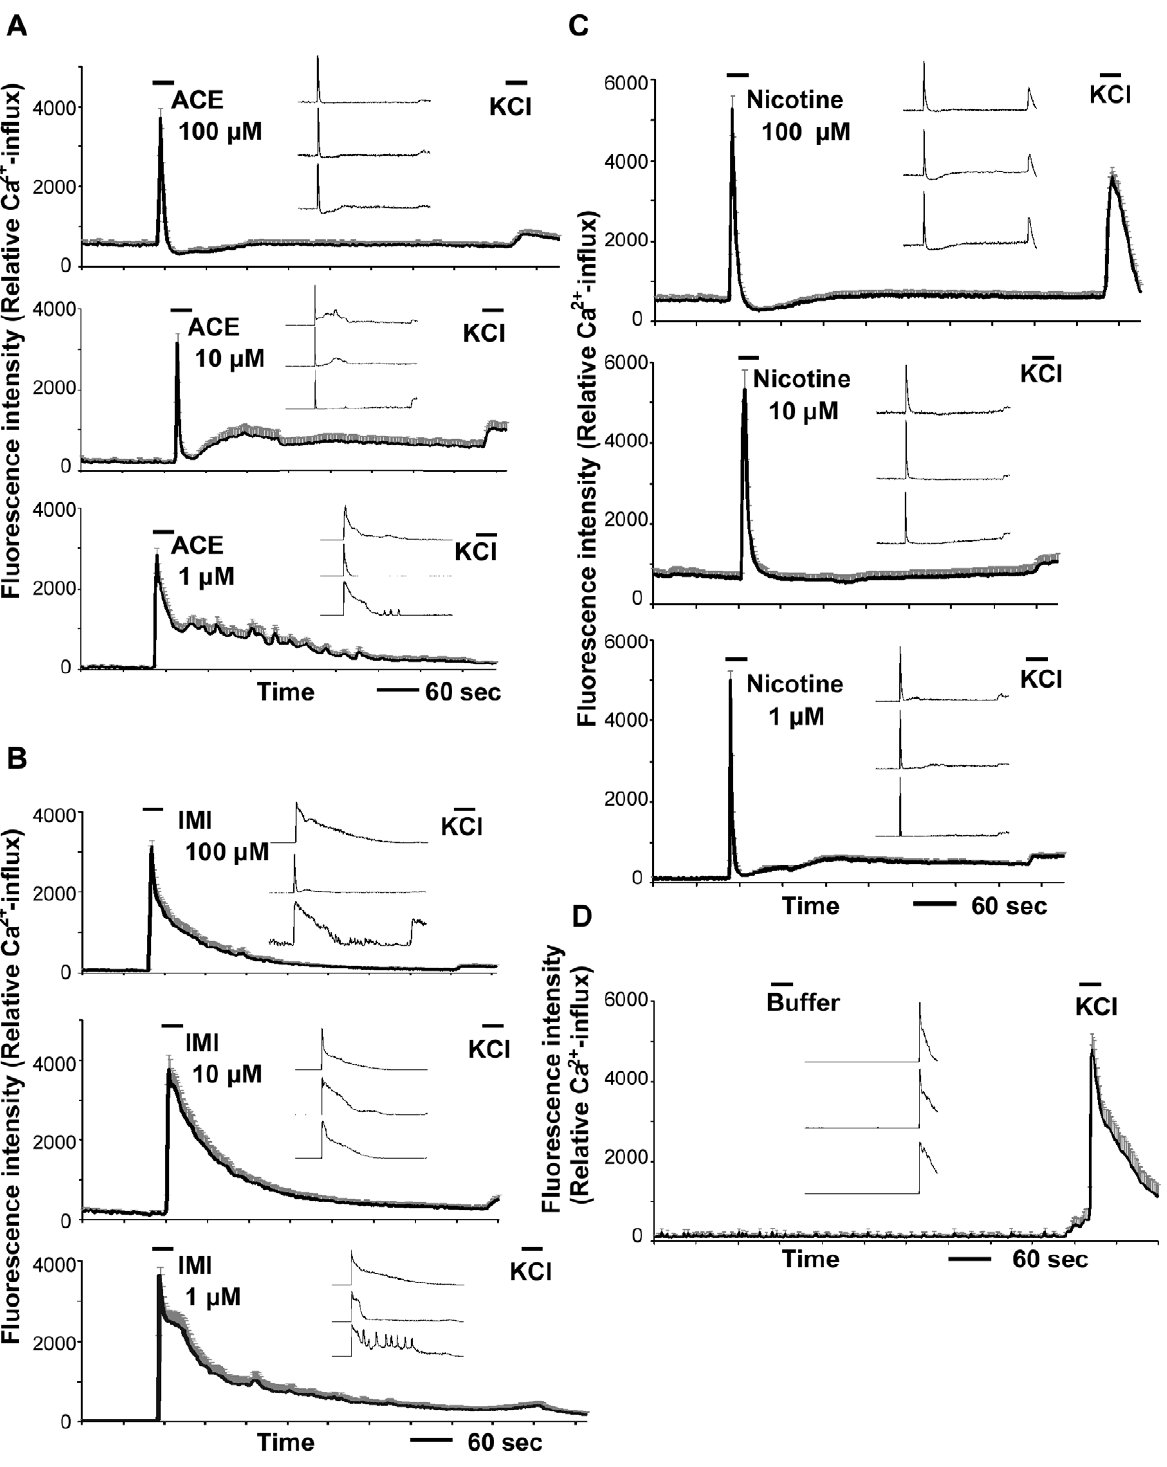
Figure 4. Effects of nicotine, ACE, and IMI on Ca 2 + influxes in Fluo-4-loaded cerebellar neurons. Administration of 1, 10, or 100 m M of ACE ( A ), IMI ( B ), or nicotine ( C ) evoked a significant Ca 2 + influx in neurons. As a negative control ( D ), BSS containing DMSO (0.001%) was applied instead of the agonists. After washing with BSS, KCl (100 mM) was added to stimulate the neurons. The main, line graphs represent mean values 6 the S.E.M. of the Ca 2 + -influx-fluorescence intensities in the small neurons ( n =20–30). All of the main graphs show data from a series of typical experiments in at least three independent culture assays, and the same patterns of Ca 2 + firing were confirmed. The small, line graphs inset within each main graph show the firing pattern of a single representative cell.